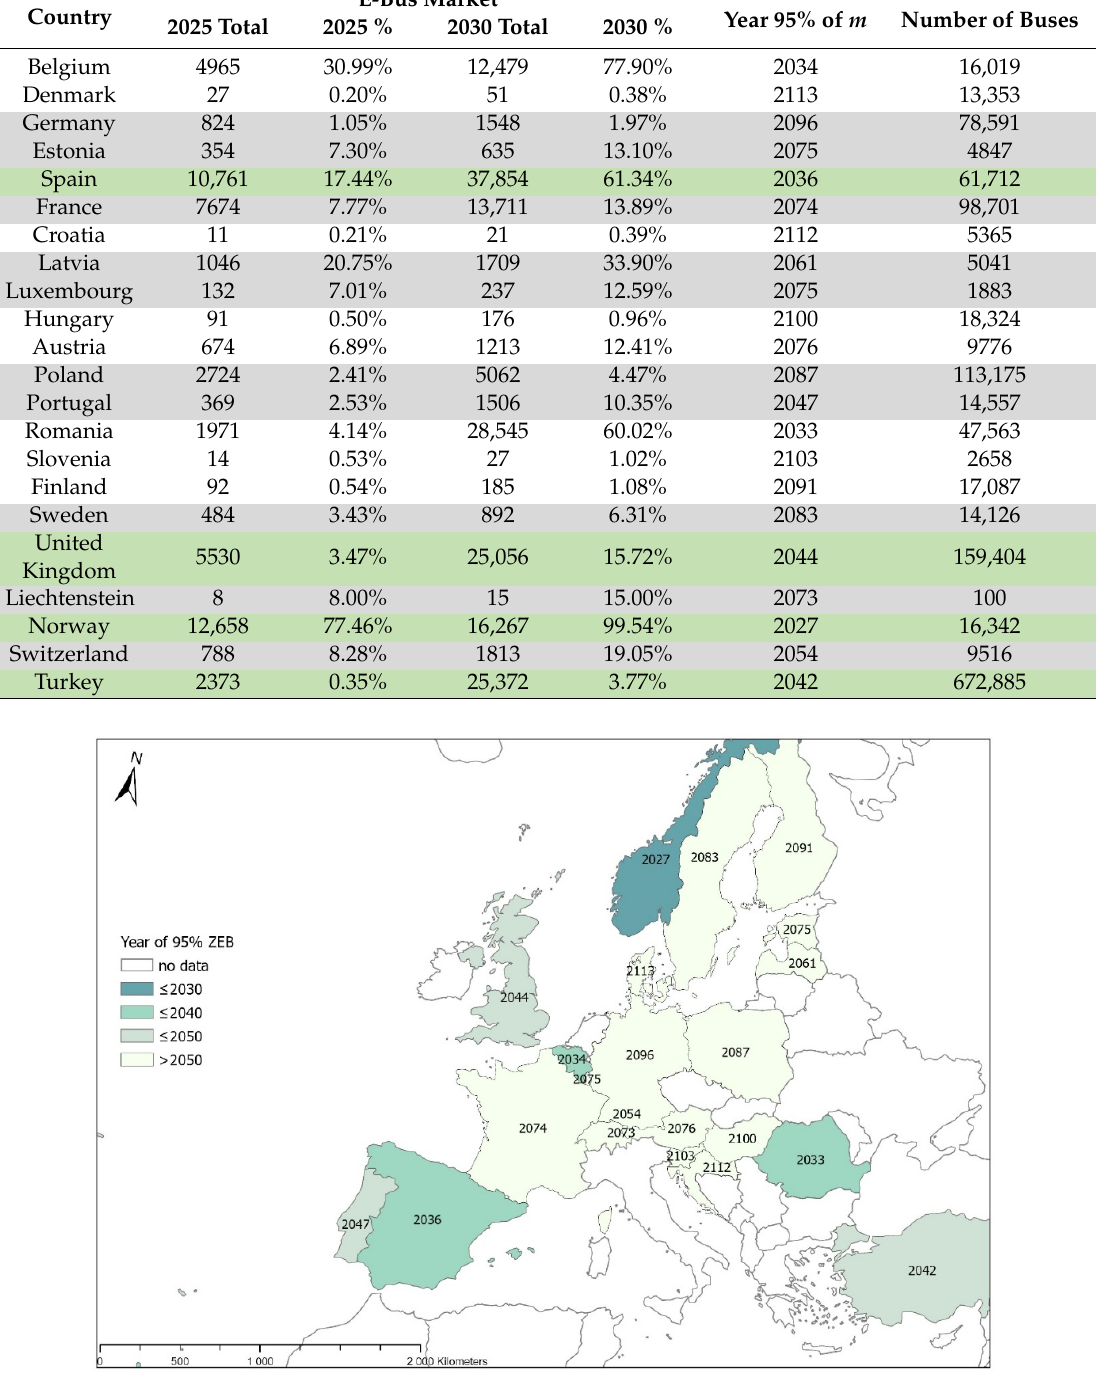
Figure 2. Geographical distribution of the year when countries reach the 95% of ZEBs in their fleets [own study].